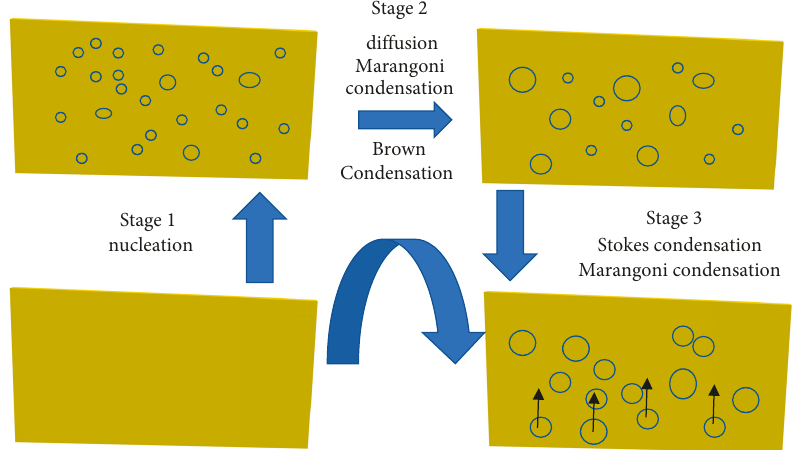
Figure 1: Three stages of two-phase separation of CuCr alloy